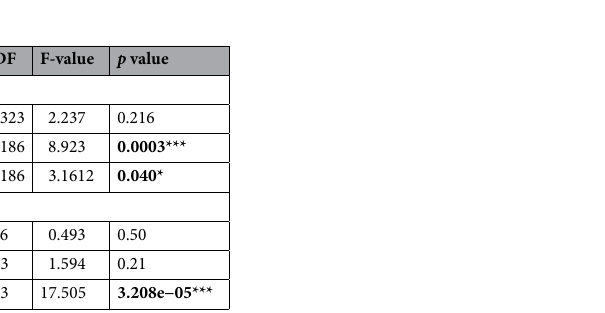
Table 2. Anova table on model for spatial tolerance (PC1) and feeding tolerance (PC2). Bold values indicate p < 0.05.